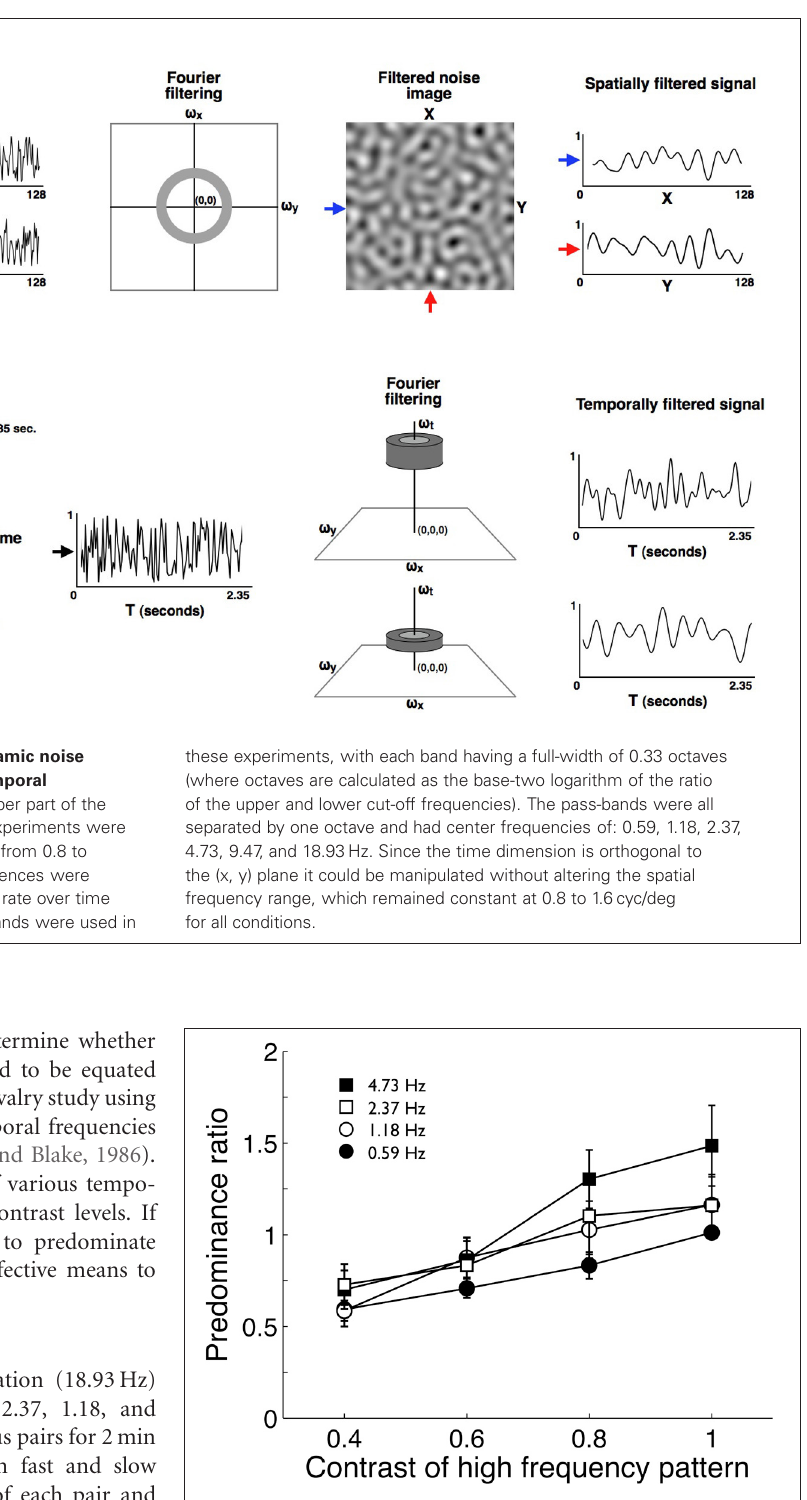
FIGURE 2 | Pilot data (group mean; n = 4) from Experiment 1 showing the predominance ratio of a high temporal frequency pattern (18.93Hz) to various lower temporal frequency patterns. The tendency of the high frequency pattern to predominate over lower frequencies declined as its contrast was reduced. Error bars show ± 1 standard error of the